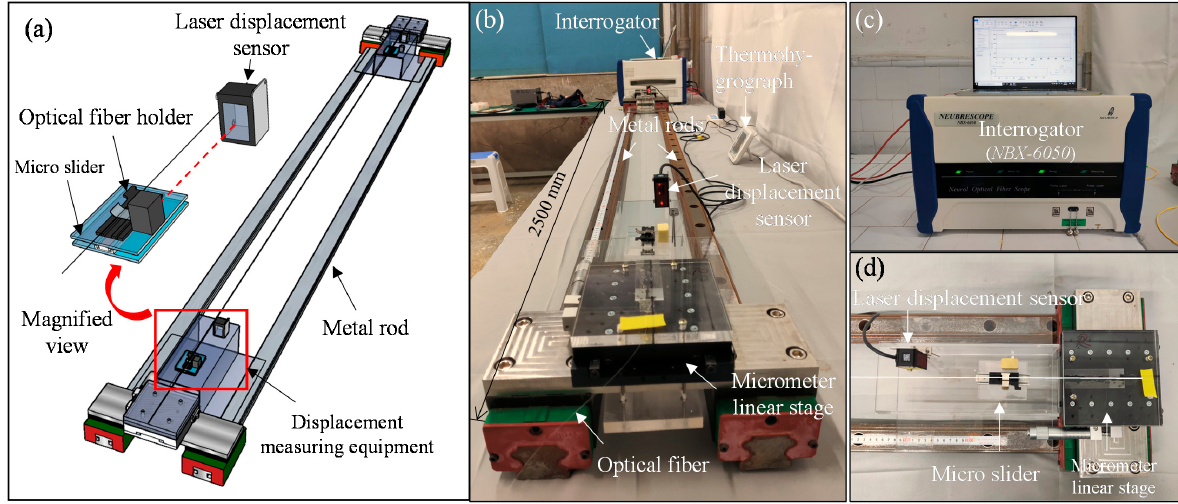
Figure 3. Calibration setup: ( a ) 3D model; ( b ) a full view of the calibration device; ( c ) BOTDA interrogator; ( d ) local top view of the calibration device.